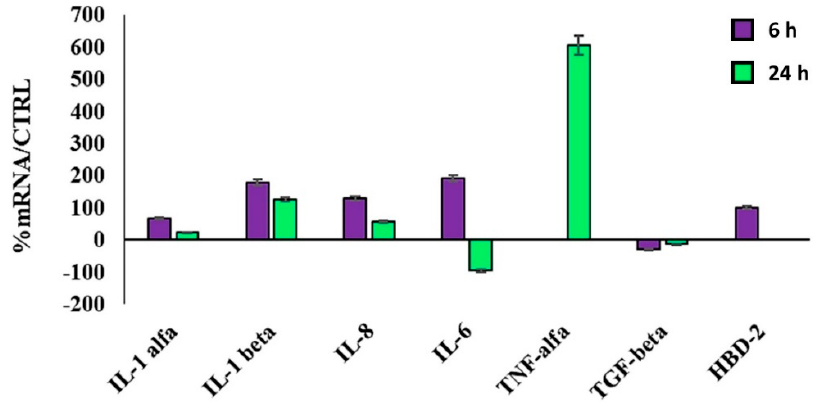
Figure 7. Relative gene expression of IL-1 (specifically, IL-1 α and IL-1 β ), IL-6, IL-8, TNF- α , TGF- β by HaCaT cells in contact with P(3HB)/P(3HO- co -3HD)/Ag for 6 h and 24 h. Data are reported as mean ± SD and are expressed as percentage of increment relative to untreated HaCaT cells (as controls; CTRL).